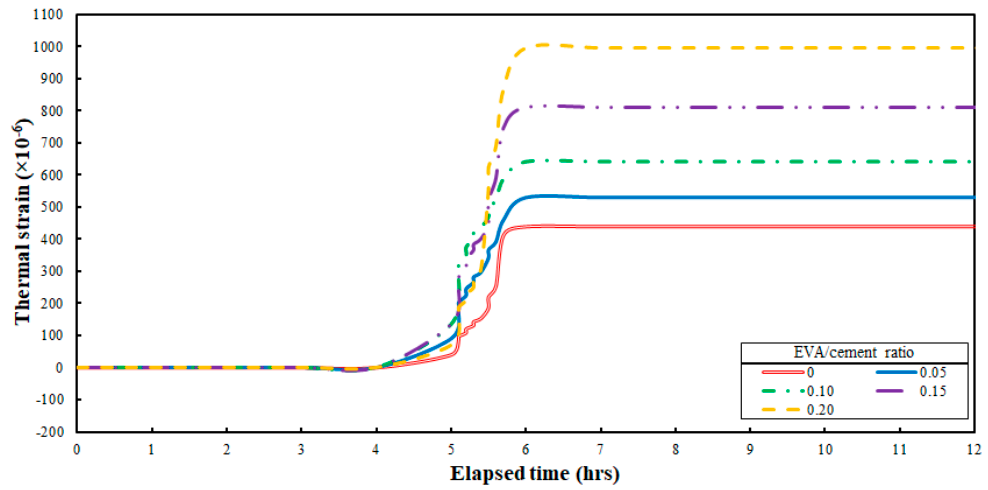
Figure 13. Thermal strains for different EVA/cement ratios.